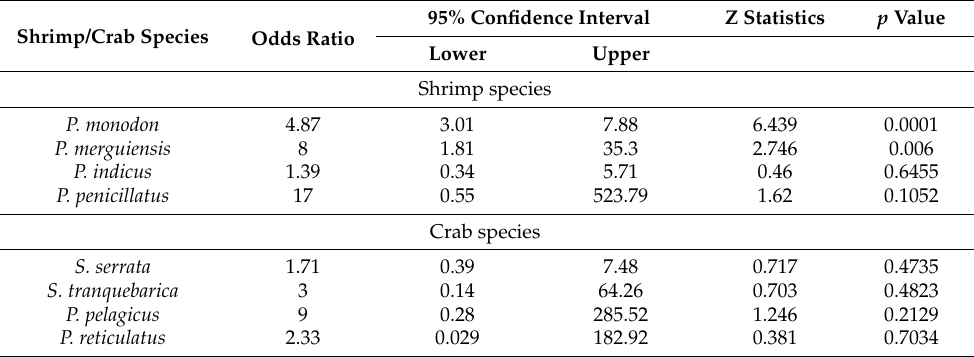
Table 3. Odds ratio values for co-infection of IHHNV and WSSV in different wild shrimp and crab species. The confidence interval was calculated by using MedCalc statistical software. If the 95% confidence interval excludes 1.0, the association is statistically significant at p < 0.05. If the 95% confidence interval includes 1.0, the association is not statistically significant at p < 0.05.